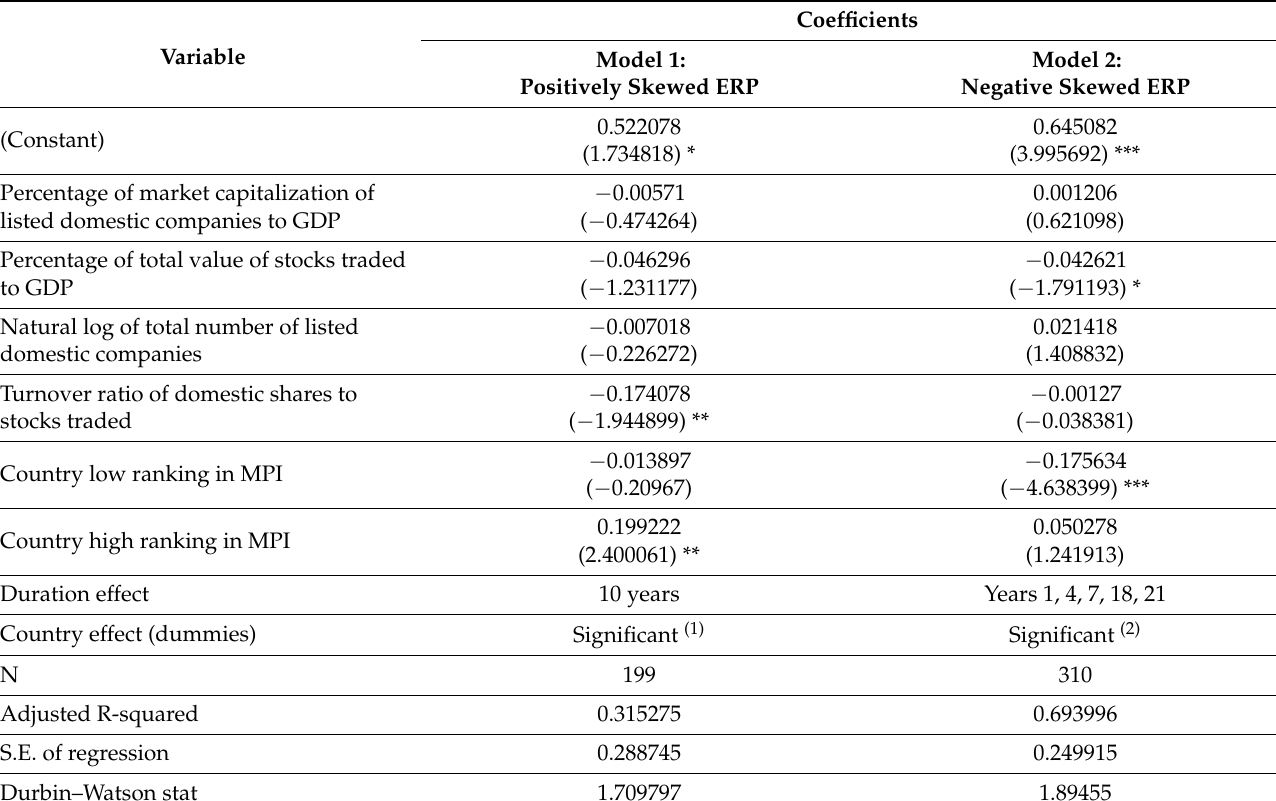
Table 5. The results for the robustness test. The dependent variable is the equity risk premium (ERP). The estimation method is fully modified least squares (FMOLS). Outliers are detected and removed. The multicollinearity is examined. All variables are associated with VIF ≤ 5. The long-run covariance estimate; Bartlett kernel; Andrews bandwidth = 9.00. The coefficients estimates are adjusted using White heteroscedasticity-consistent standard errors and